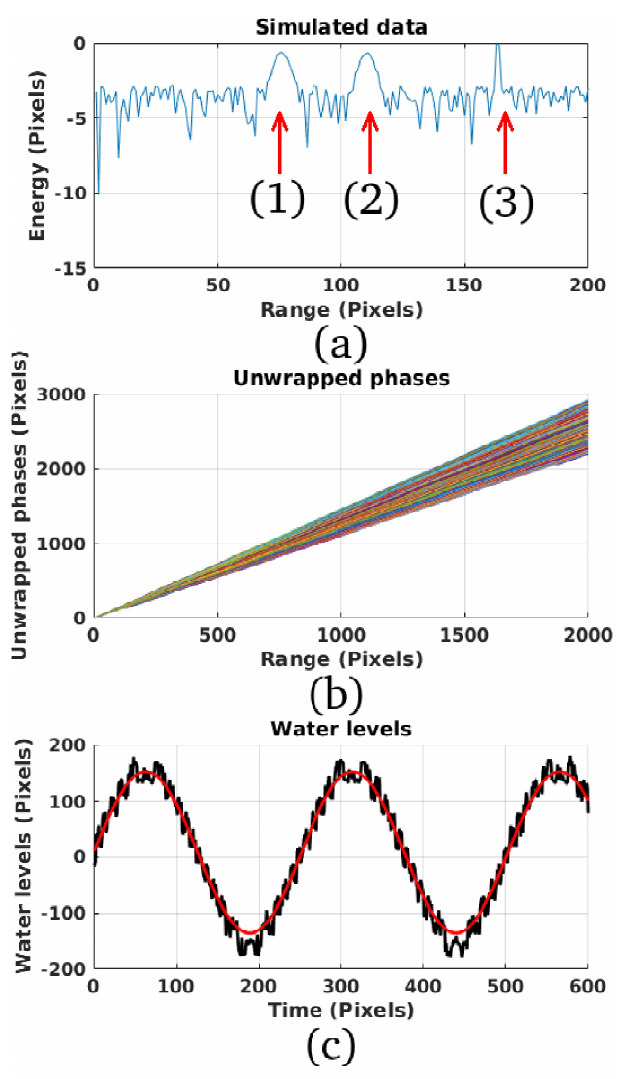
Figure 4. Results of simulated data. ( a ): reflectivity profile. ( b ): Unwrapped phases. ( c ): water-levels estimated results